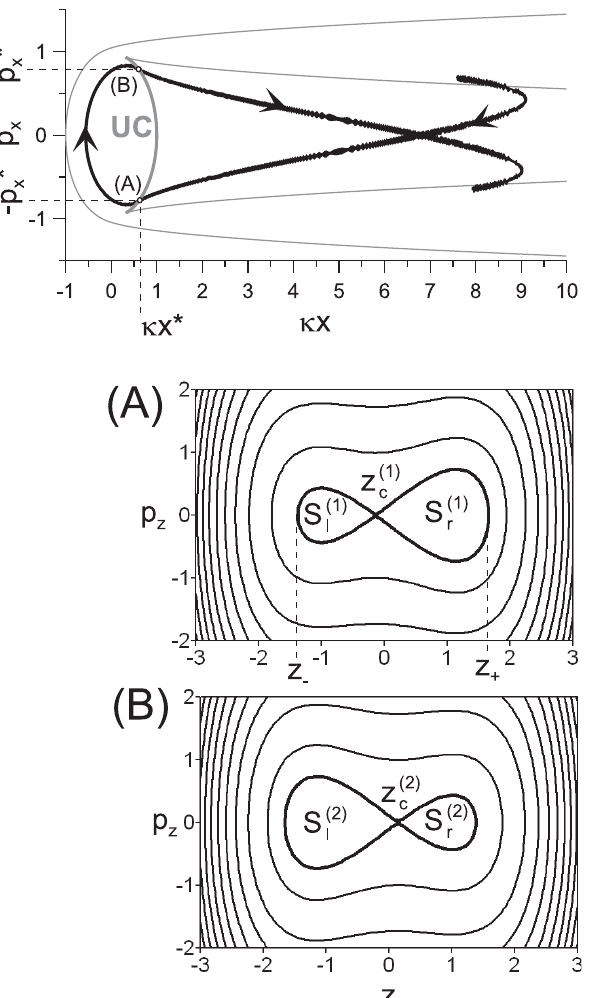
Fig. B1. Schematical view of a particle trajectory with two crossings of the uncertainty curve.